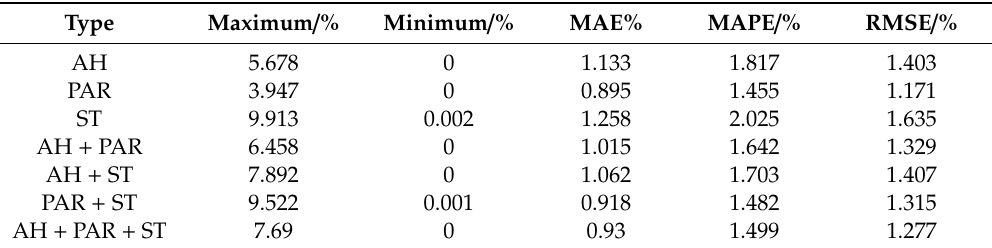
Table 10. Error list for di ff erent